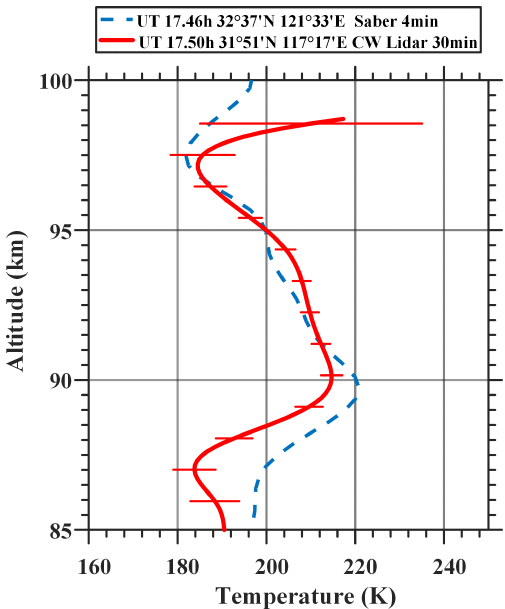
Figure 6. Comparison of temperature profiles between PMCW- NSL (solid red line) and SABER (dashed blue